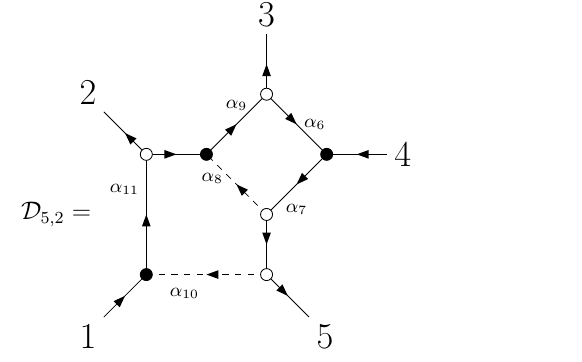
Figure 7 . On-shell diagram for a 5-point MHV amplitude. To obtain the amplitude, sum over the exchange 2 ↔ 3